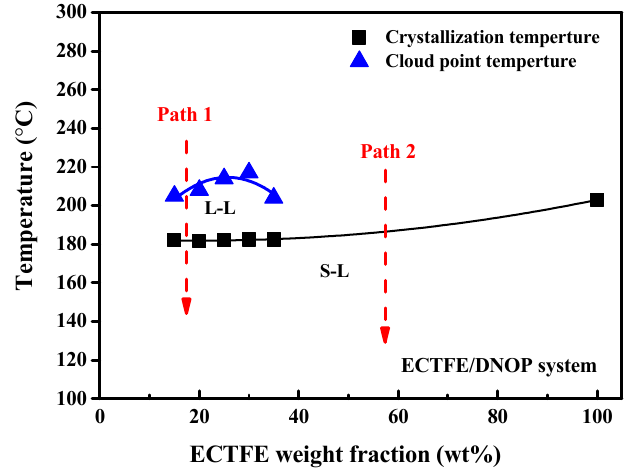
Figure 3. Phase diagram of ECTFE/DnOP system.